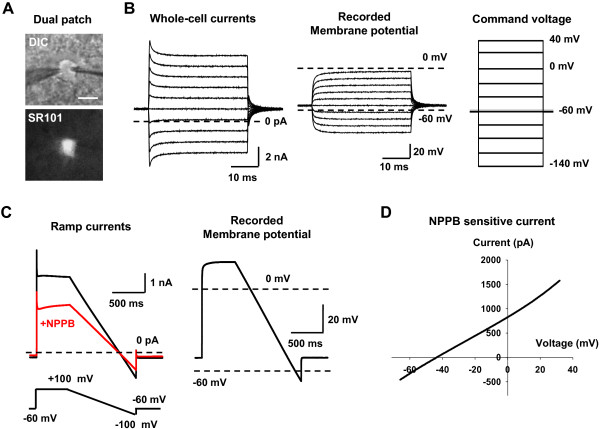
Dual-patch clamp from hippocampal astrocyte reveals the voltage error that accounts for the shift in reversal potential of the Ca2+-activated anion conductance. A. DIC Image of single hippocampal astrocyte loaded with SR101, with two electrodes sealed on the cell somata. Scale bar: 10 μm. B. The whole cell current recorded from the right electrode and real membrane potential recorded from the left electrode. Command voltages were stepped from -140 mV to +40 mV with an increase of 20 mV. The holding potential was -60 mV. C. The ramp currents recorded from the right electrode and actual membrane potential recorded from the left electrode (Average of 5 sweeps). Ramp protocol was given from +100 mV to -100 mV. D. The representative I-V relationship of subtracted current between before and during NPPB application represents NPPB sensitive current.